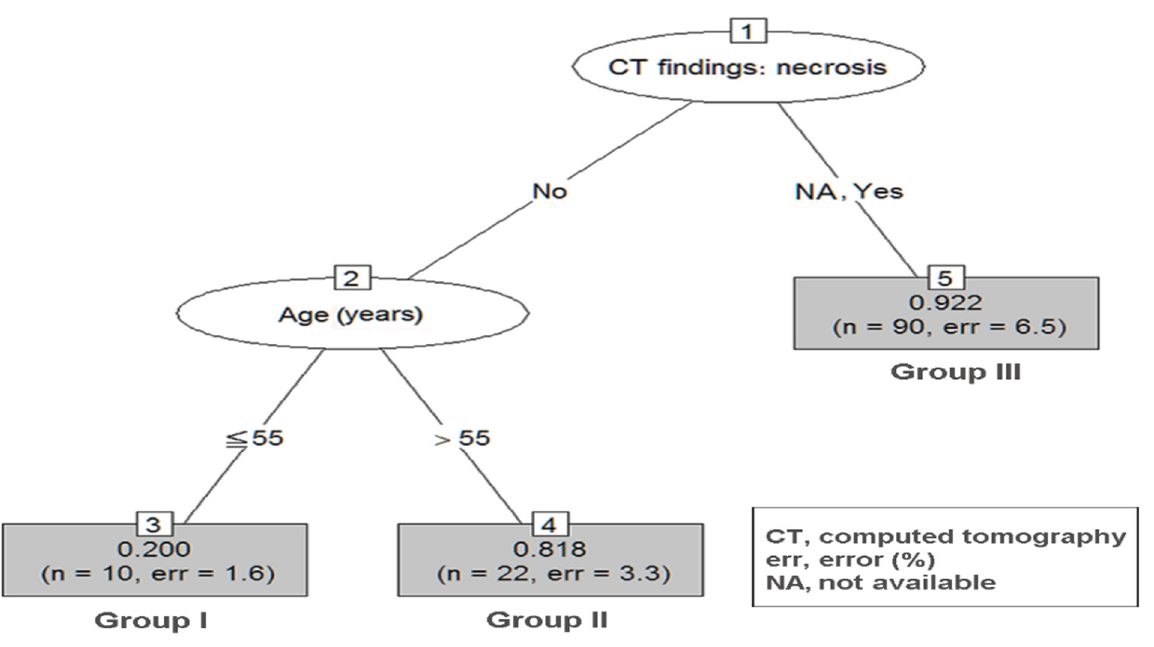
Figure 3. RPA of group 5–10 GSETs. Decision tree constructed by RPA in group 5–10. The prediction accuracy in RPA is 0.89. GSETs, gastric subepithelial tumors; RPA, recursive partitioning analysis.